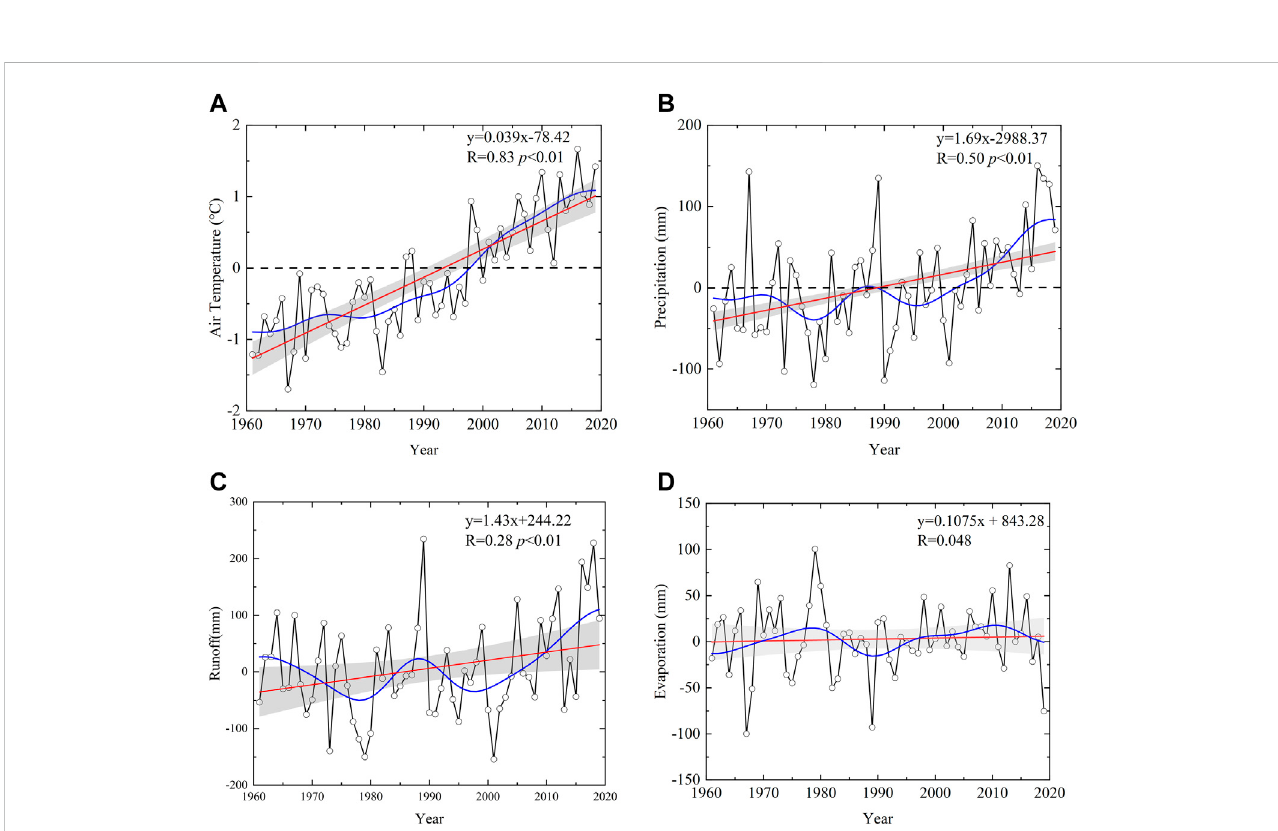
FIGURE 5 Anomalies ofmean annual air temperature (A) ,precipitation (B) , river runoff (C) , and lakesurfaceevaporation (D) with respect to the 1981 – 2010 mean in Qinghai Lake basin from 1961 through 2019. The 1981 – 2010 mean air temperature was − 0.3 ° C, precipitation was 376.3 mm, river runoff was 280.9 mm, and evaporation was 924.4 mm, respectively. Also included are individual annual anomalies (black lines with open circles), the linear trend from 1961 to 2019 (red lines), the Fast Fourier Transform smoothing (blue lines), and 0.95 con fi dence interval of linear trend (gray